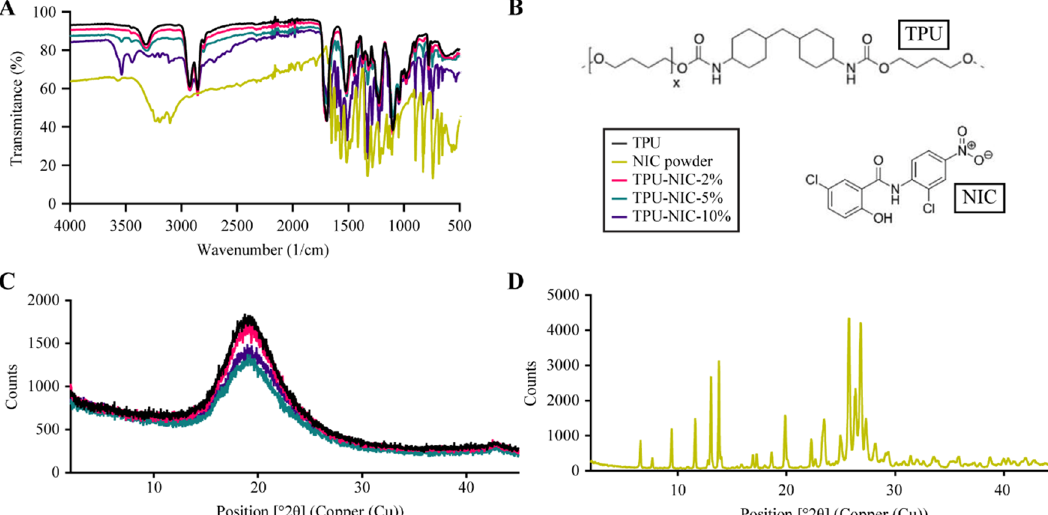
Figure 4. ( A ) FTIR spectra shown as the transmittance (%) of NIC, NIC-loaded and non-loaded TPU catheters ( n = 3), ( B ) Molecular structure of TPU and NIC used in this study, ( C ) X ray powder diffraction pattern of non- loaded TPU catheters and TPU catheters loaded with 2, 5 and 10% (w/w) NIC and ( D ) NIC plain drug